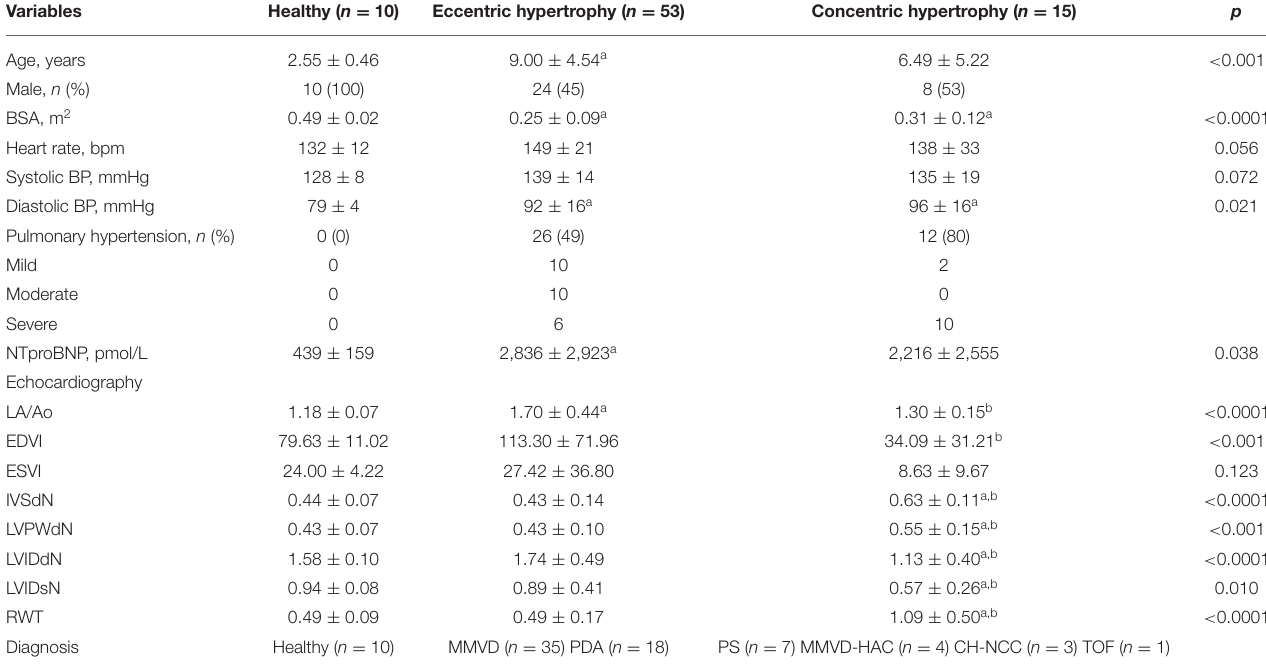
TABLE 2 | Clinical characteristics of dogs included in the classification by cardiac hypertrophy type. Variables